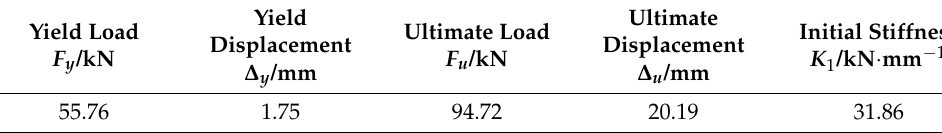
Table 2. Parameters of dampers.